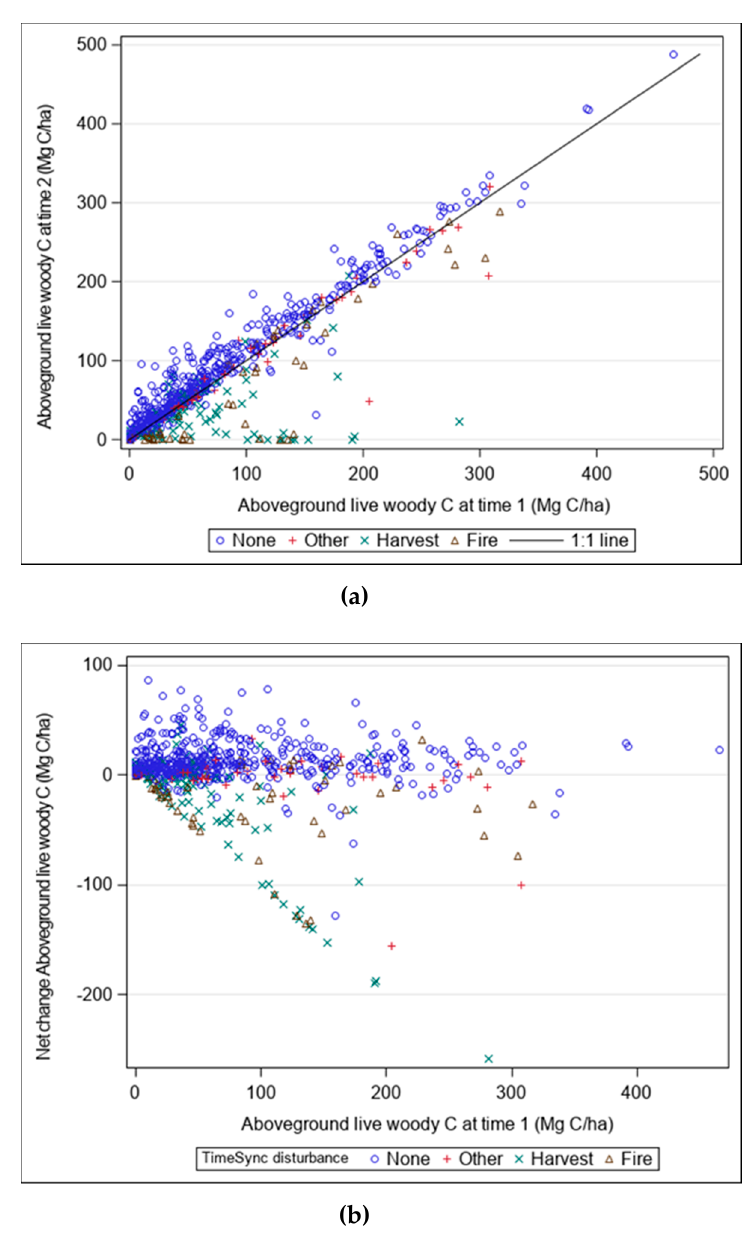
Figure 4. Change in live tree above-ground woody carbon (AWC) between measurements, by TimeSync type of disturbance, as ( a ) AWC at both times, and ( b ) net change in AWC vs. AWC at time 1.